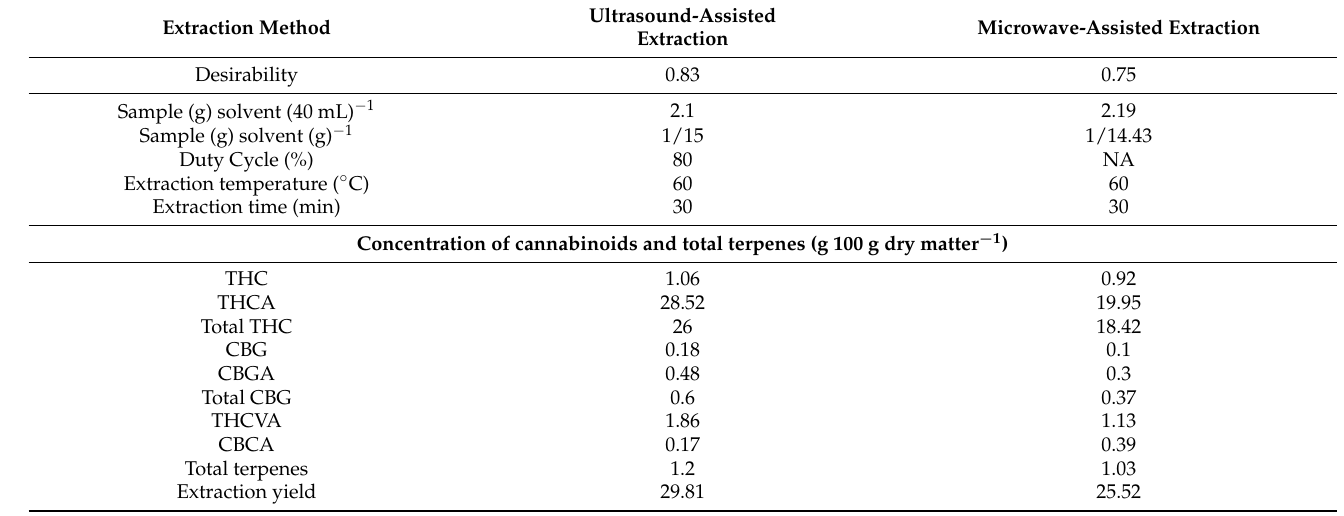
Table 7. Optimal experimental conditions for ultrasound-assisted and microwave-assisted extraction systems and predicted response